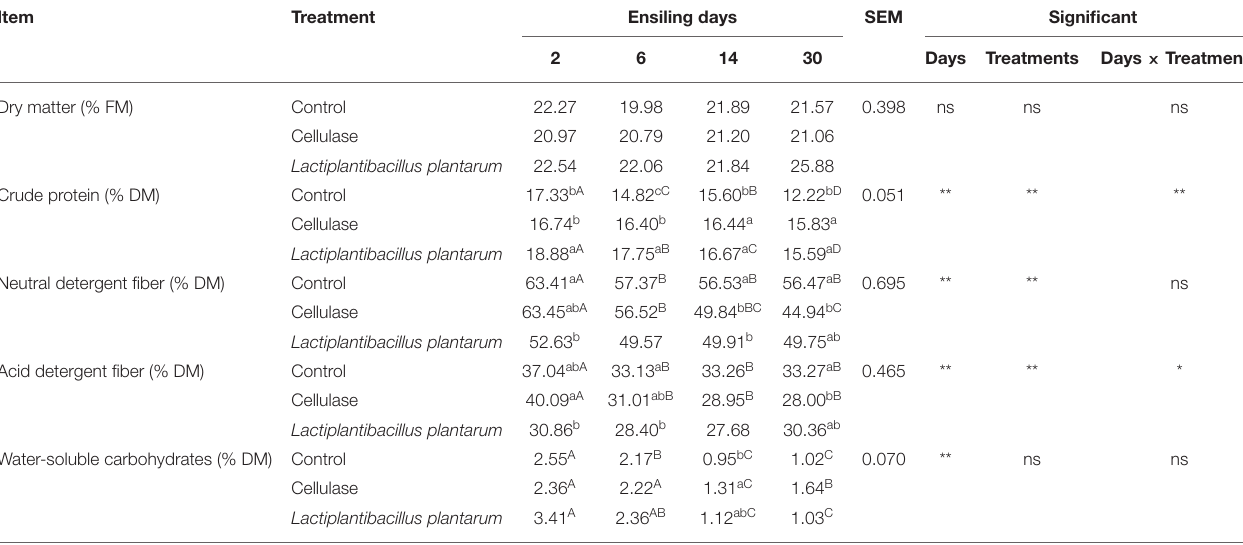
TABLE 3 | Nutrients of ensiled Cassia alata .